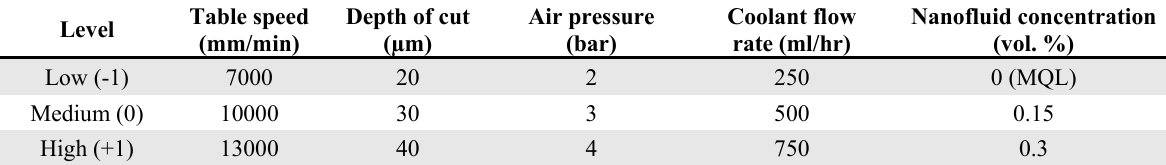
Levels of process